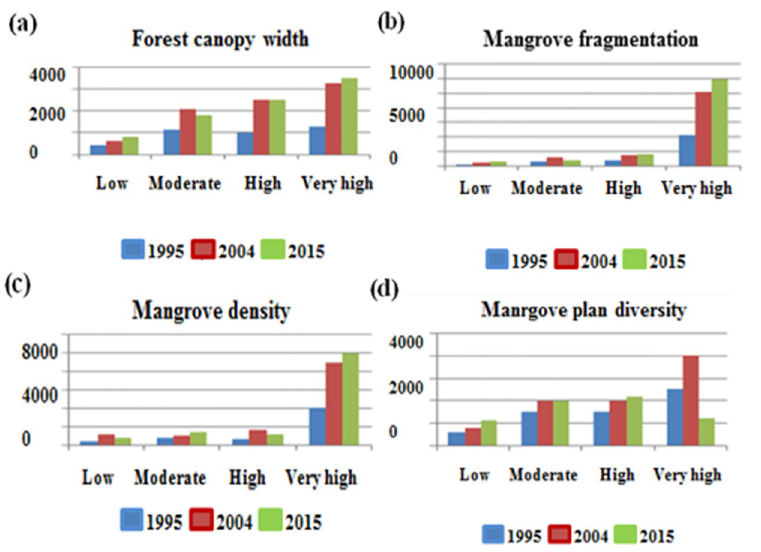
Fig 14. Changes of the mangrove health influencing factors overtime.